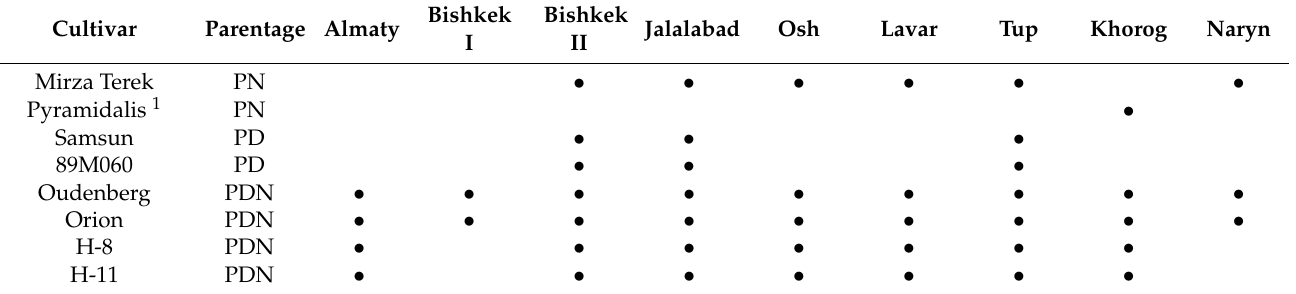
Table 1. List of poplar cultivars, corresponding parent species, and distribution across sites. Parentages refer to the following species and hybrids: PN— P. nigra (section Aigeiros), PD— P. deltoides (section Aigeiros), PT— P. trichocarpa (section Tacamahaca), PA— P. alba (section Populus), Psi— P. simonii (section Tacamahaca), PPa— P. pamirica (section